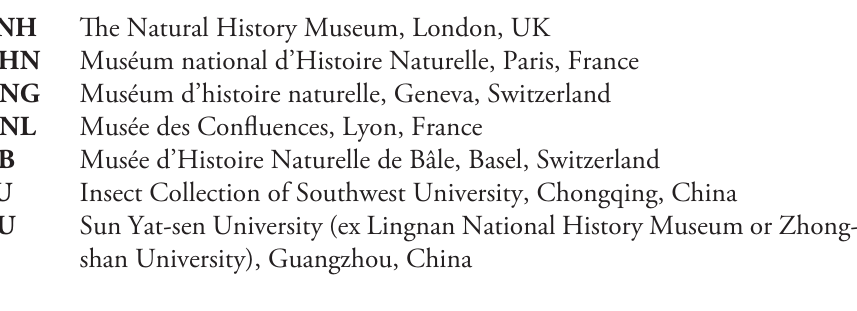
Oberea flavescens Breuning, 1947: 146. Type locality: China, Sichuan. Oberea atropunctata v. flavescens : Breuning 1962: 169. Redescription. Body (Fig. 1) 17.5–17.9 mm long and 3.0 mm wide. Head ochre­ ous, apical mandible dark brown; antennae reddish brown, scape dark brown; ventral surface (except the abdominal sternite II and III black) and legs pale yellowish brown, tarsi darker. Body clothed with short golden pubescence and some erect hairs on pro­ notum, base of elytra and ventral surface of the basal antennal segments. Head slightly narrower than prothorax, vertex distinctly depressed at middle with a groove; eyes very large, inferior lobes twice as long as the gena in male and 1.5 times in female. Antennae distinctively shorter than body, reaching the apical fourth of elytra, antennomere ratio: 12.3: 2.5: 16.0: 15.8: 15.8: 15.9: 15.7: 15.4: 13.5: 12.6: 12.5 in males and 14.1: 3.0: 14.8: 14.2: 14.1: 14.9: 15.3: 15.1: 14.8: 14.4: 13.6: 13.5 in females. Prothorax wider than long; apical and basal margins slightly emarginated; sides rounded at middle, slightly constricted basally and apically; pronotum raised in middle, finely and densely punctured. Scutellum squared, slightly emarginated. Elytra very long, nearly 5.5 times as long a humeral width, and 4.5 times as long as head and prothorax